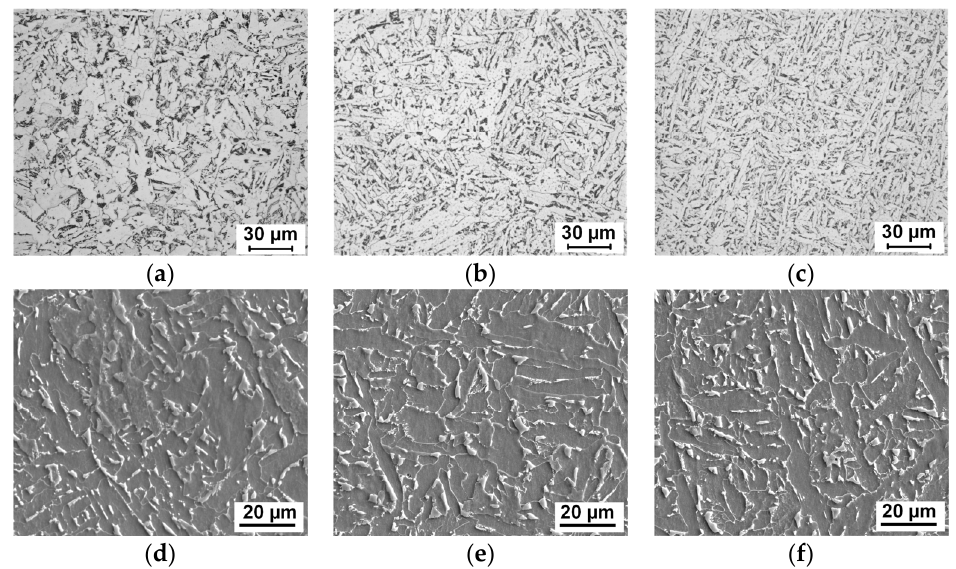
Figure 4. Optical ( a – c ) and SEM ( d – f ) microstructures formed with austenitizing temperatures of ( a , d ) 1000 ° C, ( b , e ) 1200 ° C, and ( c , f ) 1400 ° C.